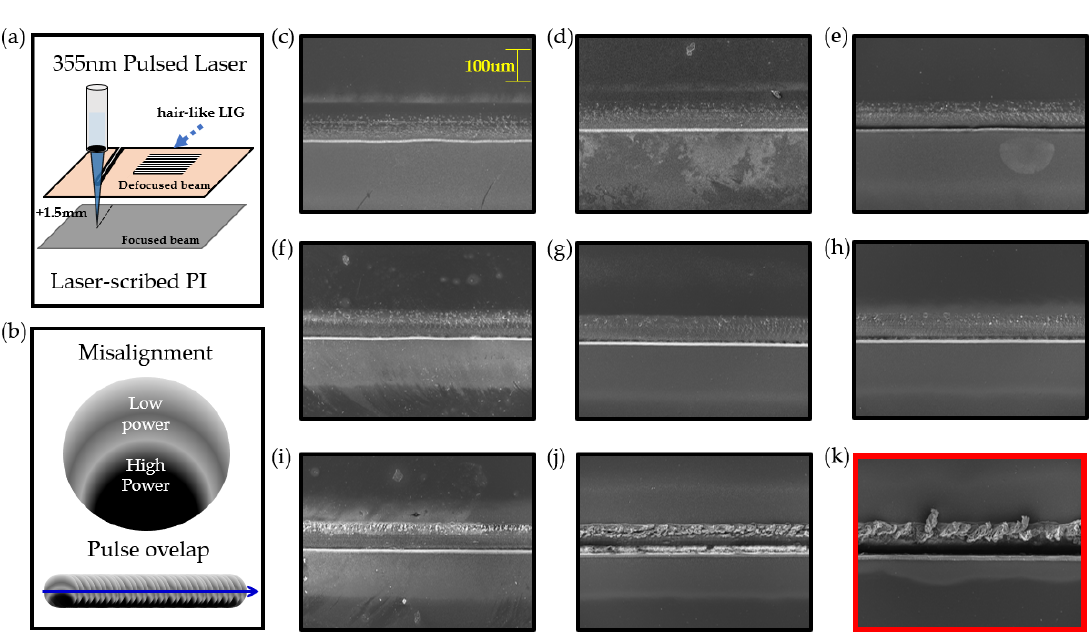
Figure 3. ( a ) Schematic illustration of 355 nm pulsed laser condition (defocused beam), ( b ) illustration of the power intensity distribution of a laser pulse, ( c – j ) FE-SEM images of line pattern fabricated with the laser speed of 90, 80, 70, 60, 50, 40, 30 and 20mm/s, ( k ) FE-SEM image of line pattern with LIG flakes fabricated at 10